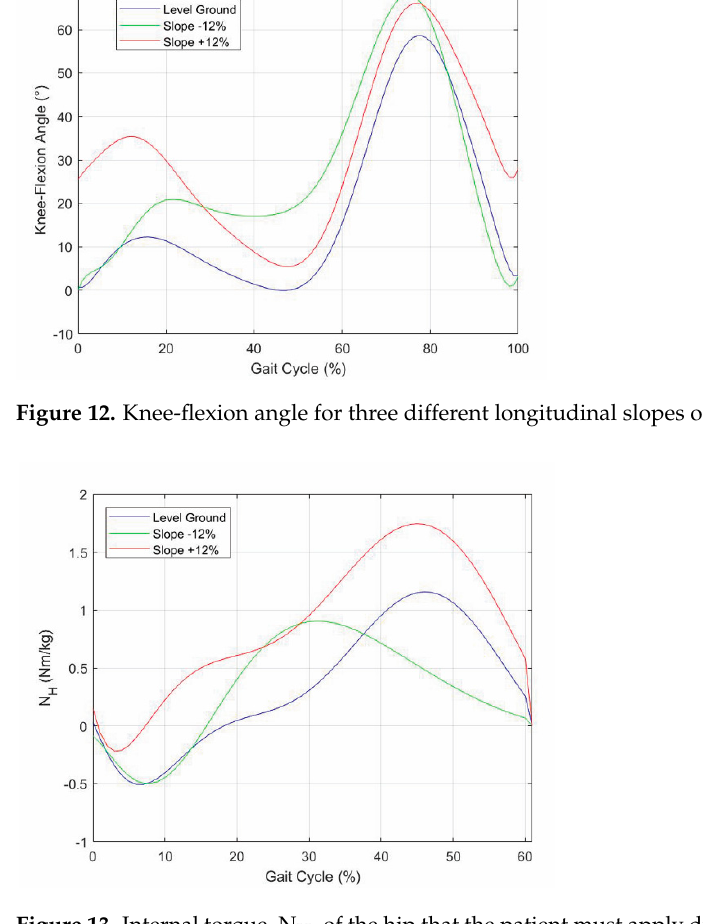
Figure 14 . Internal torque, M K , of the knee that the prosthesis actuation system must provide for making the prosthetic knee mimic the asymptomatic motion on walkways with three different lon- gitudinal slopes.